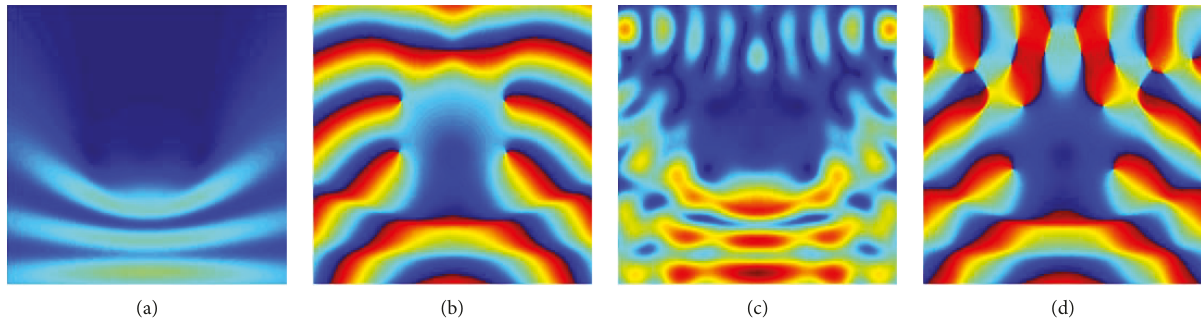
Figure 8: Amplitude (a, c) and phase (b, d) of the fi eld for Leg2 in water without casing (a, b) and with casing (c, d). The fi eld is displayed over a square subregion of width 36